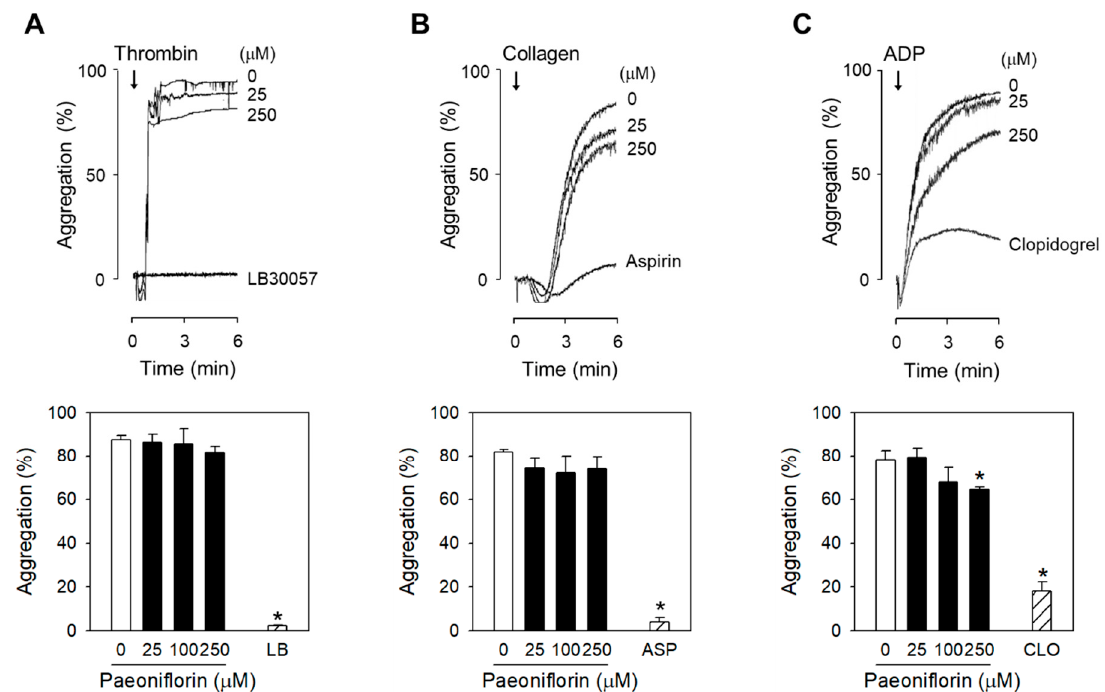
Figure 2. Selective effects of paeoniflorin on SIPA. ( A – C ) Various concentrations of paeoniflorin were treated with human PRP for 10 min, and then stimulated by thrombin (0.6–0.8 U/mL) ( A ), collagen (2–4 µg/mL) ( B ), or ADP (5–10 µM) ( C ), respectively ( n = 3). The platelet aggregation was measured